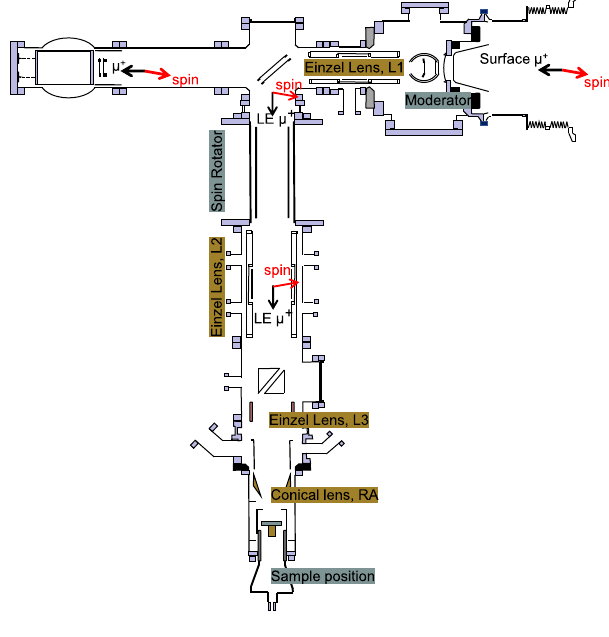
FIG. 2. The layout of LEM